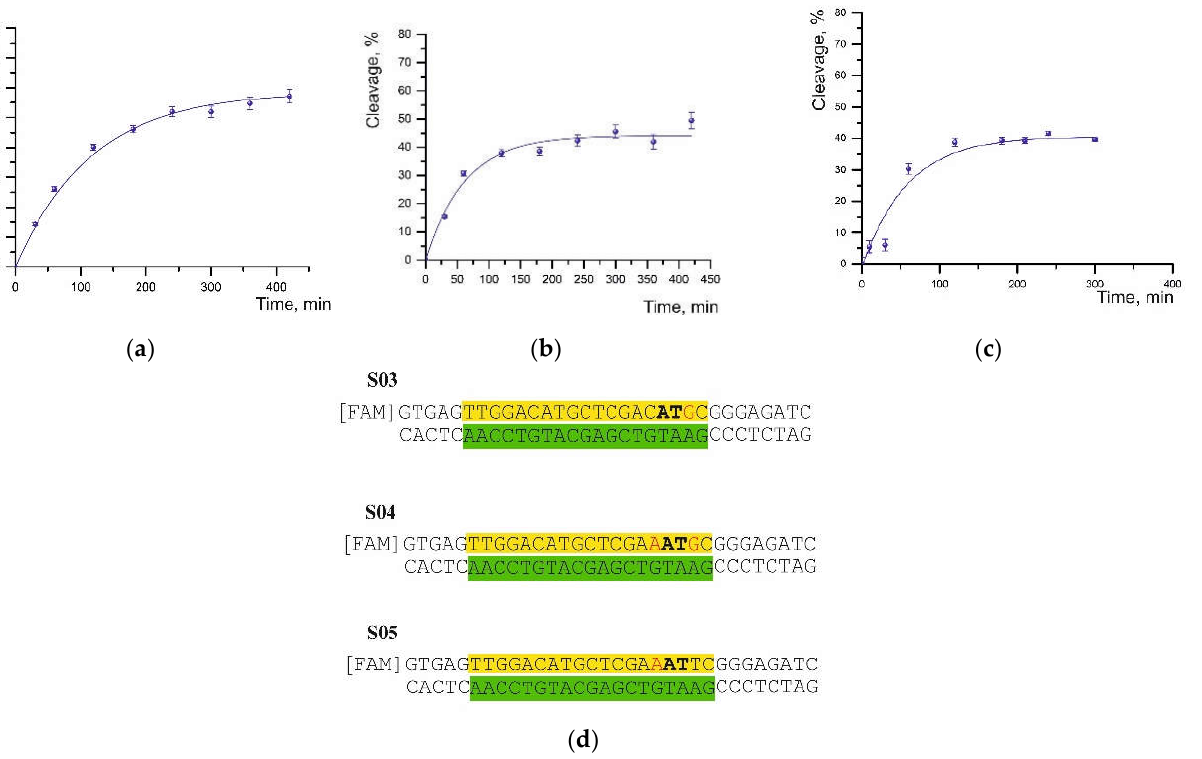
Figure 3. The time curve of the cleavage of substrates ( a ) S03, ( b ) S04, and ( c ) S05. The data were averaged from three independent experiments. The degree (%) of cleavage and error can be found in Table 1. ( d ) The sequences of DNA substrates (S03, S04, and S05). The cleavage site is boldfaced, and the sequences forming a complementary duplex are highlighted in green and yellow.